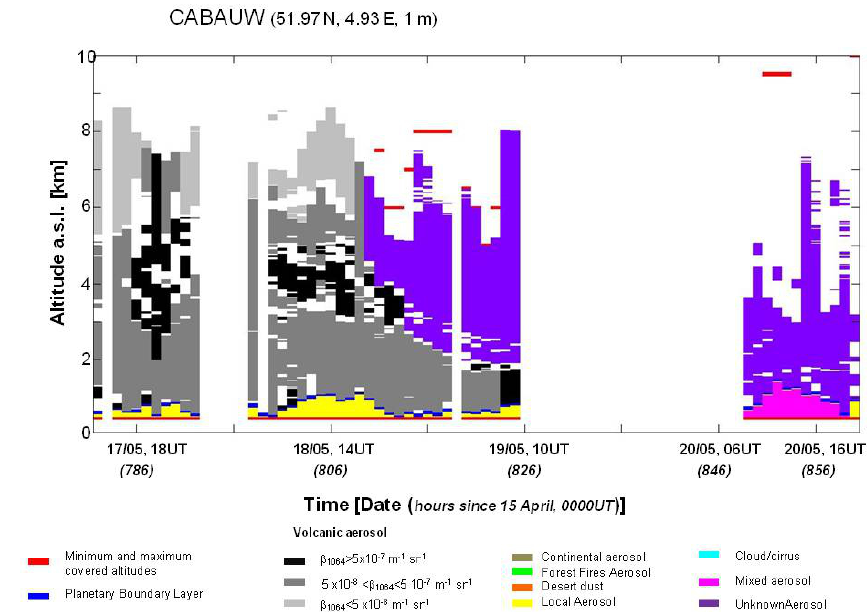
Fig. 4. Aerosol mask for the Cabauw EARLINET site in the 17–20 May 2010